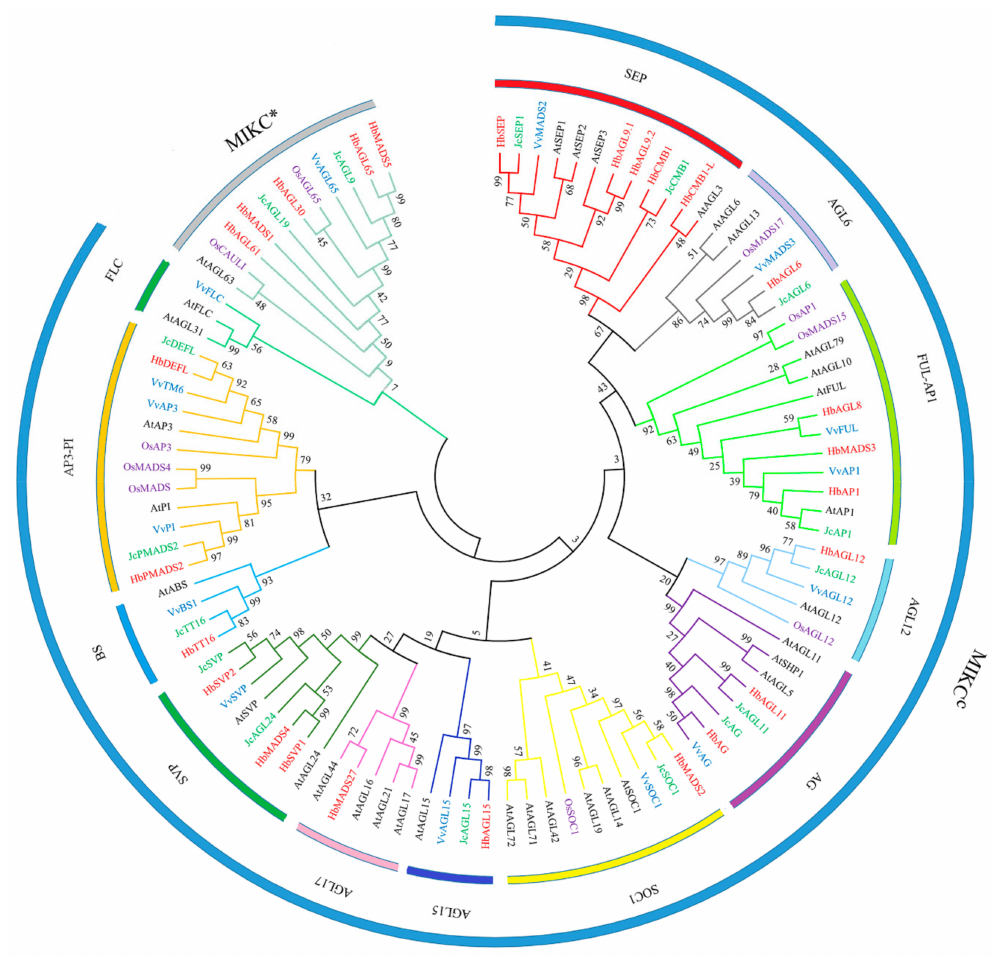
Figure 2. Phylogenetic analysis of HbMADS-box genes with other MADS-box genes by MEGA version 6.0. A phylogenetic tree of MADS-box genes was generated by the neighbor-joining (NJ) method. The multiple sequence alignment and construction of phylogenetic tree were performed with MEGA6.06 using the neighbor joining method with 1000 bootstrap replicates. The proteins were clustered and divided into three distinct sub-families. The three sub-families were further divided into 12